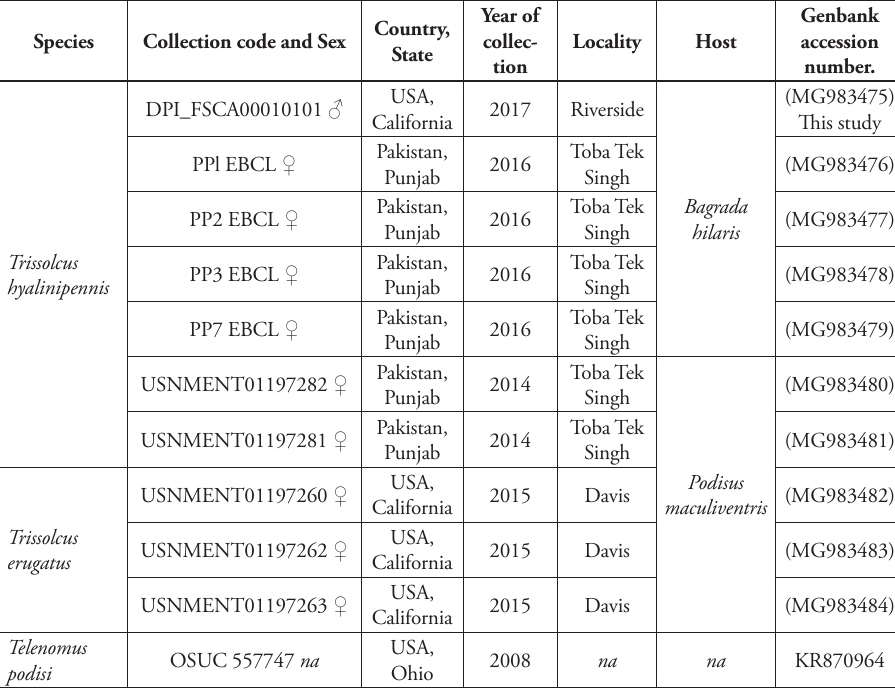
The Genbank accession numbers MG983476-84 were given to the above specimens that had been collected